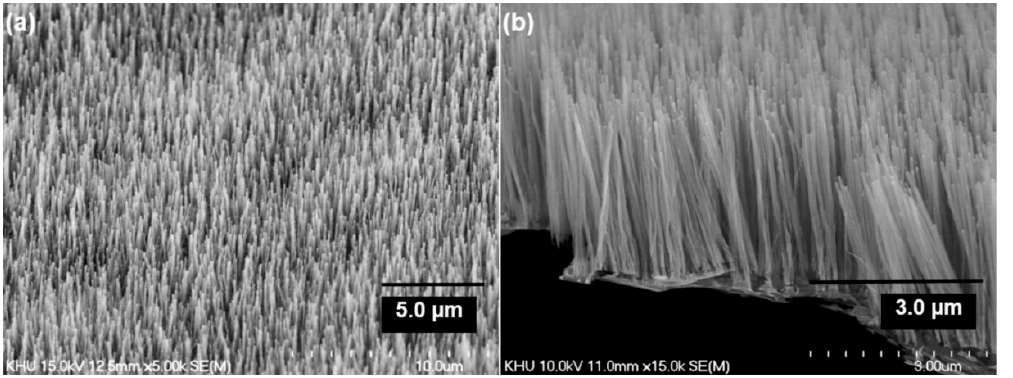
Figure 21. ( a ) Top- and ( b ) side-view SEM micrographs VACNT grown on flexible graphite foil via PECVD, reported from [48].